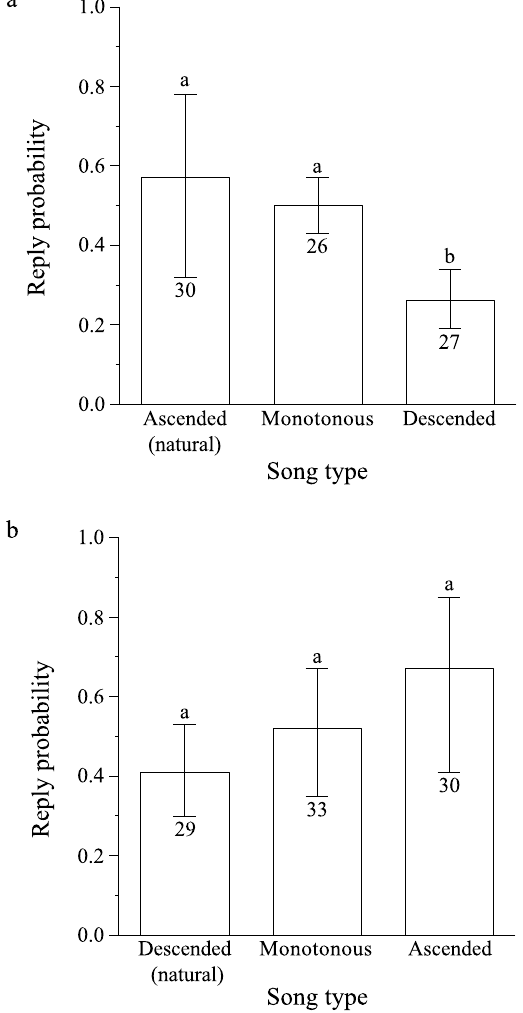
Figure 4. Reply rates ( ± 95% Wald Confidence Intervals) to playback experiments. ( a ) SetA (descending playbacks) – reply rates to natural, ascending control songs (N ASC ) and synthetic monotonous (S MON ) and synthetic descending (S DSC ) versions. ( b ) SetB (ascending playbacks) – reply rates to natural, descending control songs (N DSC ) and synthetic monotonous (S MON ) and synthetic ascending (S ASC ) versions. Letters above error bars denote statistical significance (P < 0.05) and values below error bars denote number of